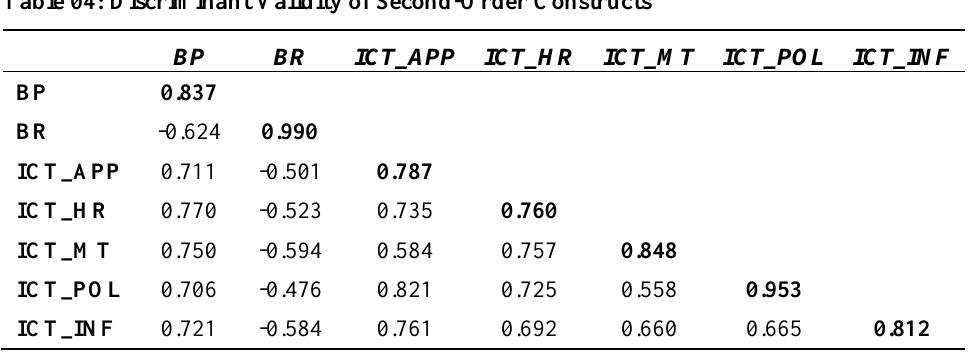
Table 04: Discriminant Validity of Second-Order Constructs